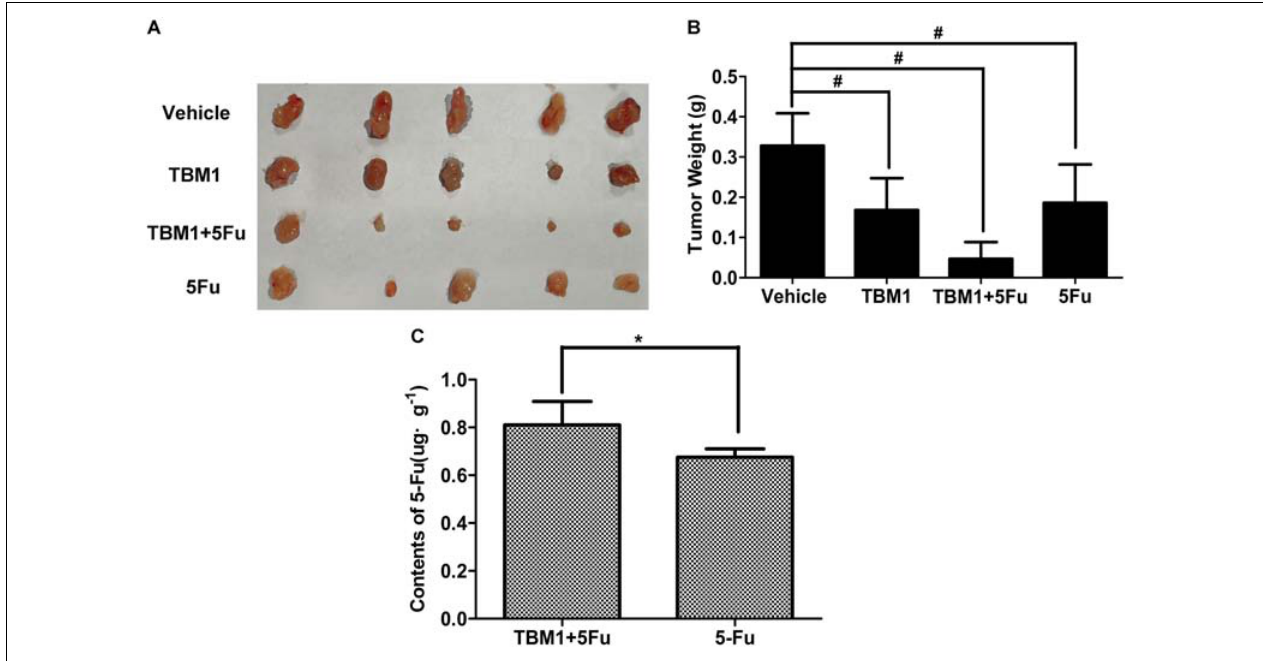
FIGURE 7 | TBM1 coordinates with 5-FU and enhances the chemotherapy effect of 5-FU in mice with CRC xenografts. (A) The illustration of tumors from four groups. (B) Tumor weight was measured and analyzed. (C) The contents of 5-Fu in cancer tissue of mice by TMB1 or the combination of TBM1 and 5-Fu after 1 h. # p < 0.01, ∗ p <